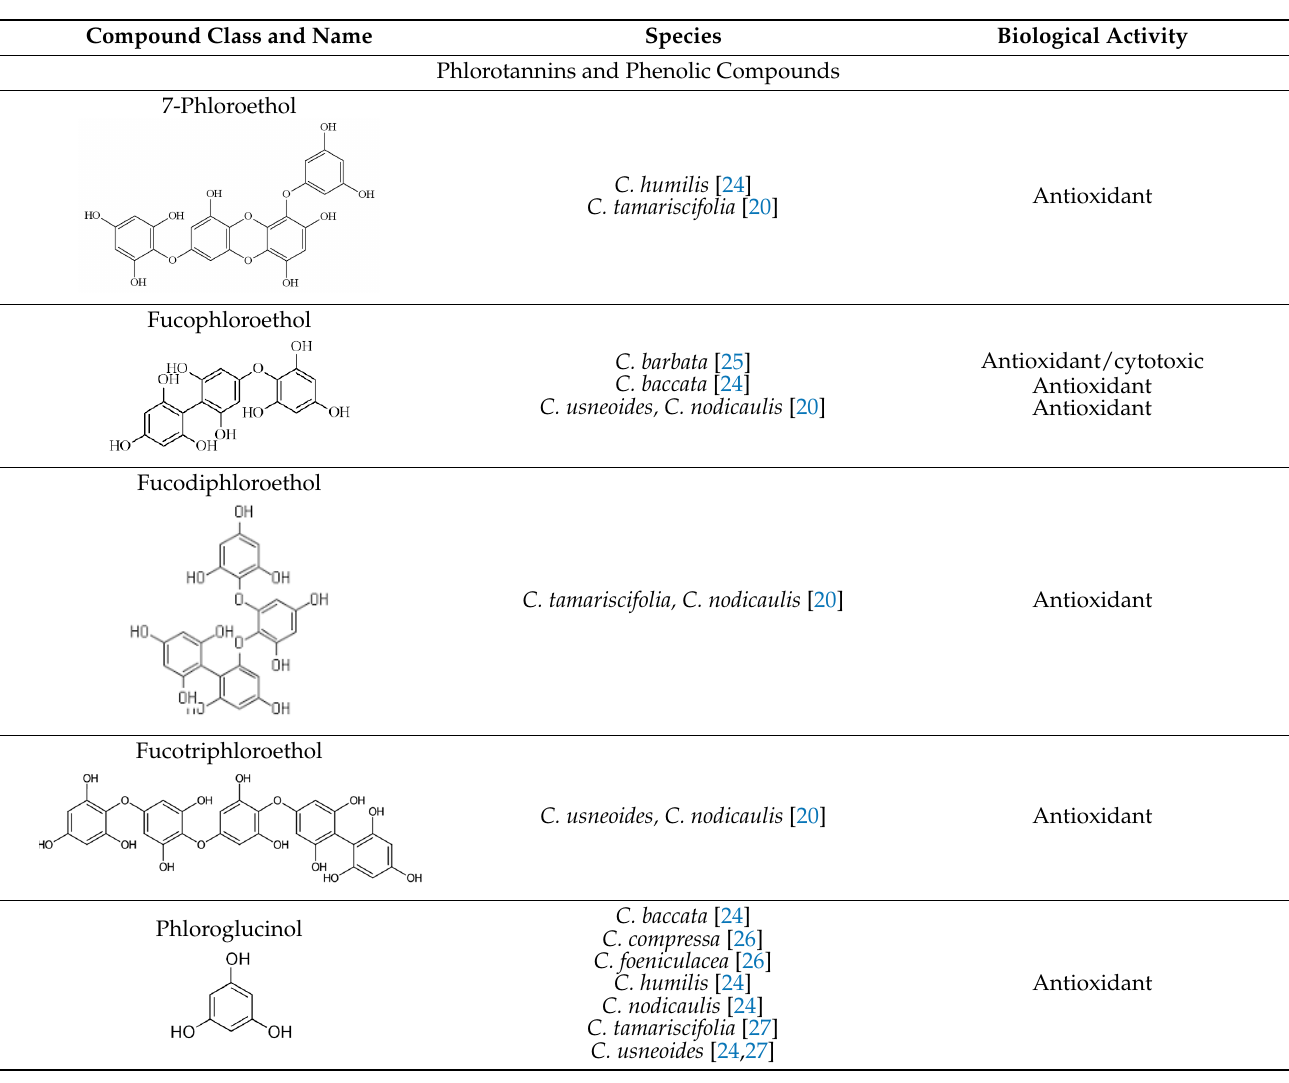
Table 1. Compounds identified in species of the genus Cystoseira and their respective biological activity.